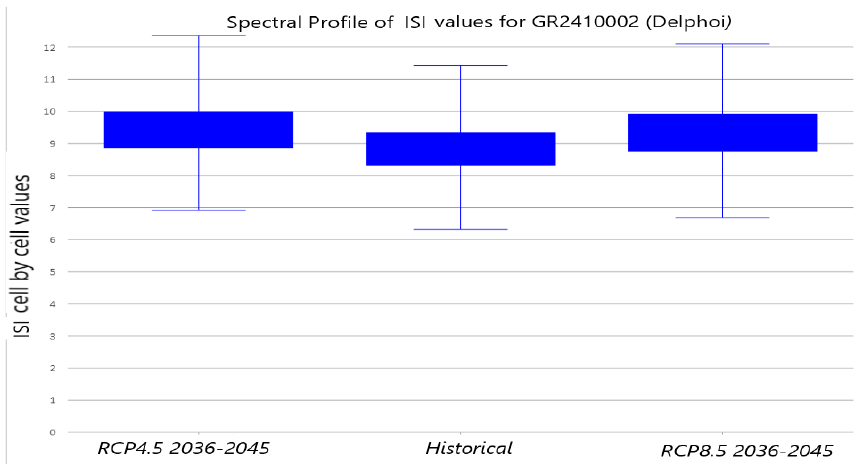
Figure 9. Bar chart of historic Initial Spread Index (ISI) Mean value, RCP 4.5 ISI Mean value and RCP 8.5 ISI Mean value by Area of Interest. Forests 2020 , 11 , x FOR PEER REVIEW 13 of 19